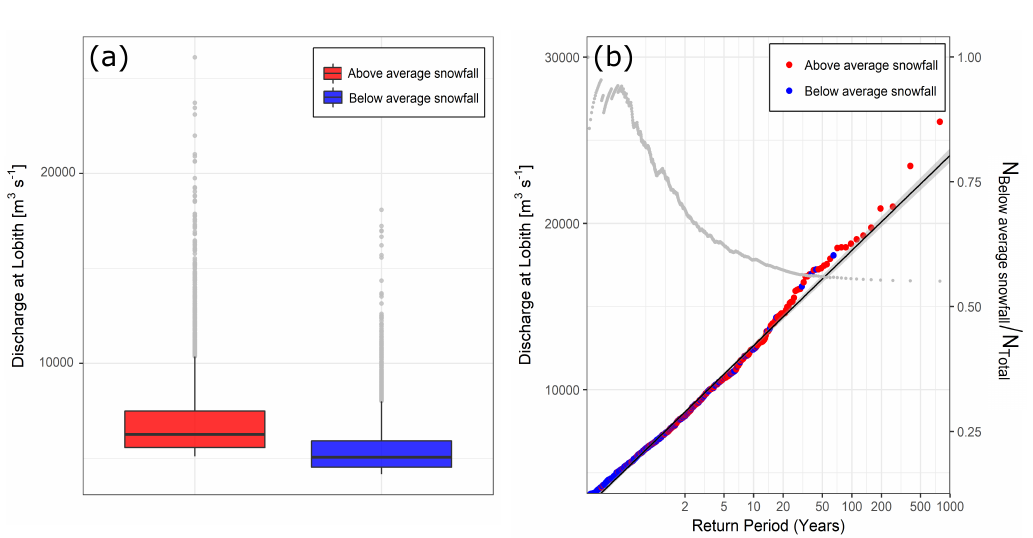
Figure 4. ( a ) Box plots for the discharge events exceeding the 95 th quantiles for the year above and below average snowfall. ( b ) Generalized extreme value (GEV) plot of annual maximum discharge for years above and below average snowfall years. The grey point shows the fraction of below average snowfall samples. Its exponential decay shows a clear preference of below-normal snowfall events for the lower discharge return periods. The grey band around the line shows the confidence interval of the linear fit.